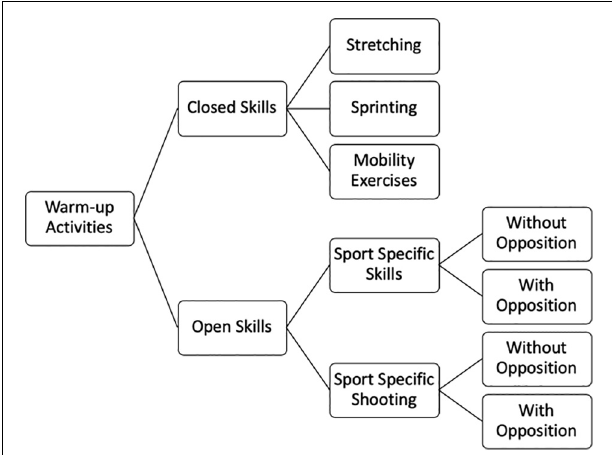
FIGURE 1 | Classification of exercises under specific categories according to their characteristics.